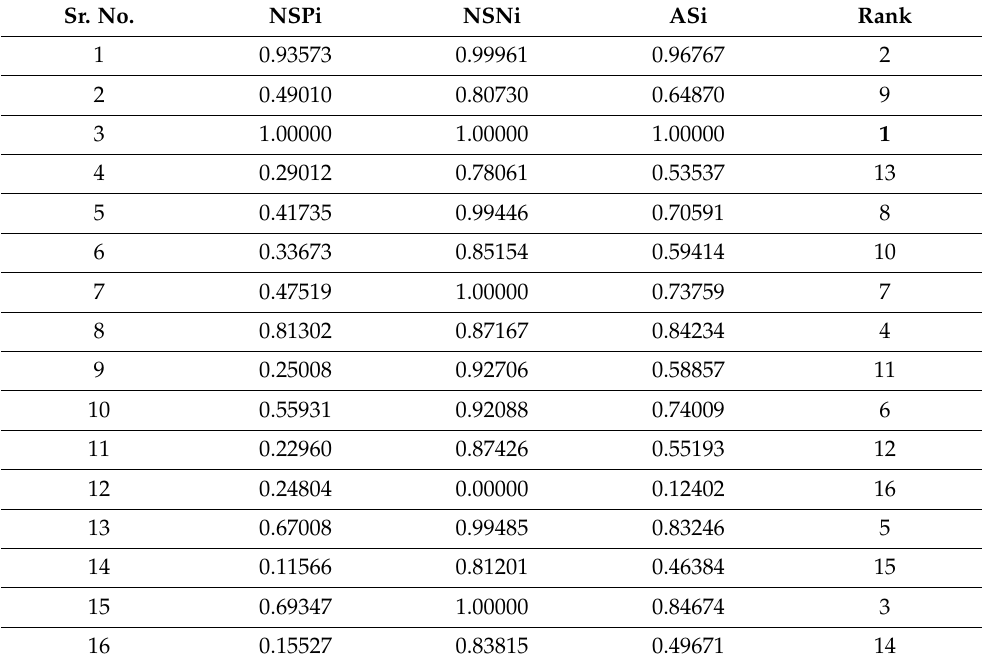
Table 11. Calculation of NSPi, NSNi, ASi and